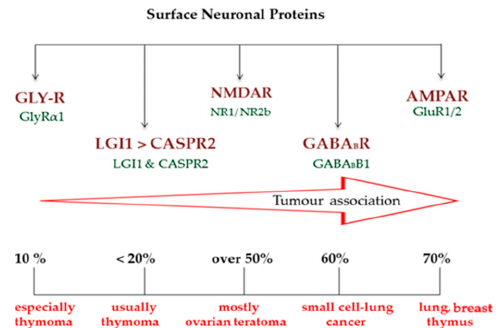
Figure 1. Schematic diagram of specific antibodies against surface neuronal proteins (leucine-rich glioma-inactivated-1 (LGI1), contactin-associated protein-like 2 (CASPR2), the N -methyl-D-aspartate receptor (NMDAR), γ -aminobutyric acid receptor-B (GABA B -R), the glycine receptor (GlyR), and a-amino-3-hydroxy-5-methyl-4-isoxazolepropionic acid receptors (AMPARs)) associated with seizure disorders. The associated autoantibodies are distributed into pathogenic entities that target extracellular neuronal areas of LGI1 and CASPR2, the NR1 and NR2b subunits of the NMDARs, the GABA B R1 subunit of the GABA receptors, the GluR1 / 2 subunits of the AMPAR (from which 70% of cases with increased AMPAR are of paraneoplastic origin), and the GlyR α 1 subunit of the GlyRs.